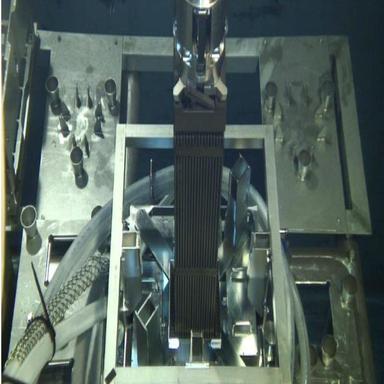
PWR fuel assembly suspended in the DDSI instrument underwater at the Clab facility in Sweden, from Ref..